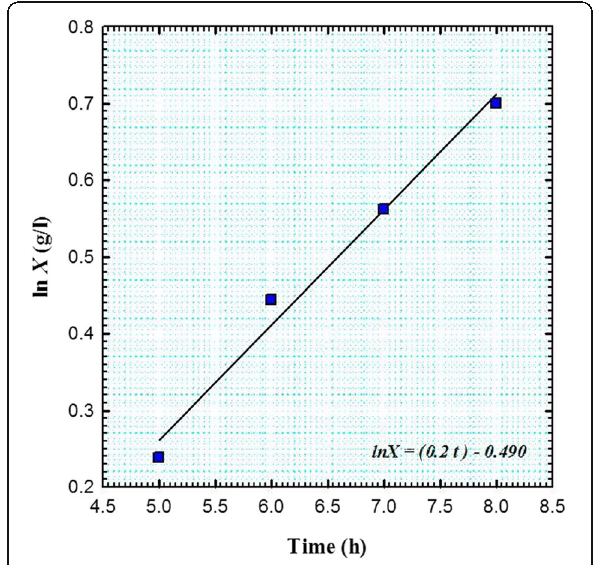
Fig. 6 Ln biomass (X) in g/l as a function of time in the exponential growth phase of batch fermentation no. 1 of Bacillus subtilis isolate